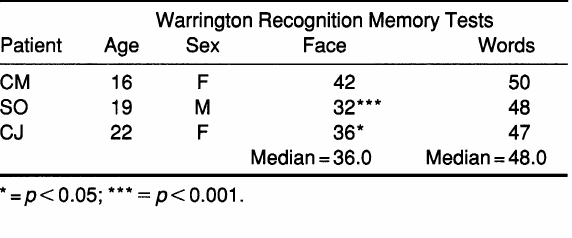
TABLE V. Data on the Warrington Recognition Memory Tests for three British schizophrenic